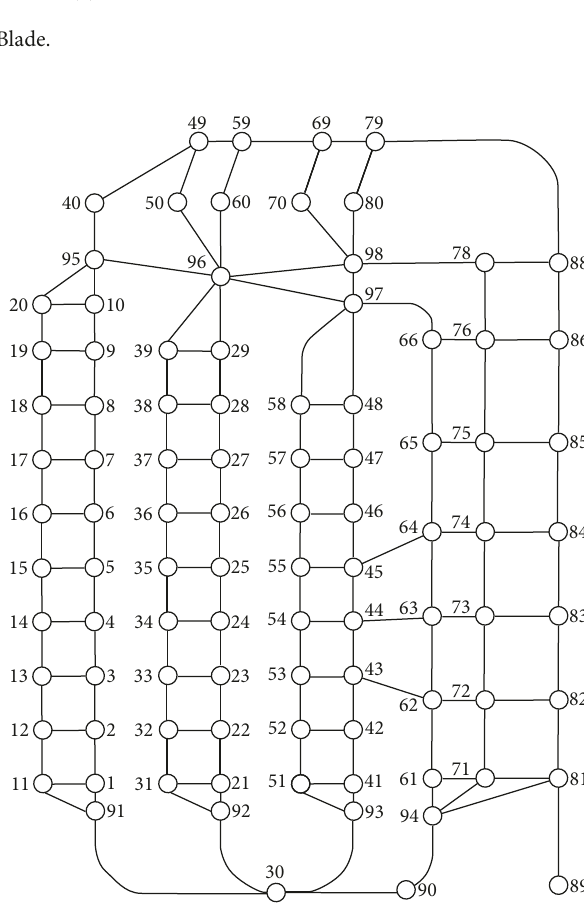
Figure 6: An equivalent hydraulic network of the blade cooling